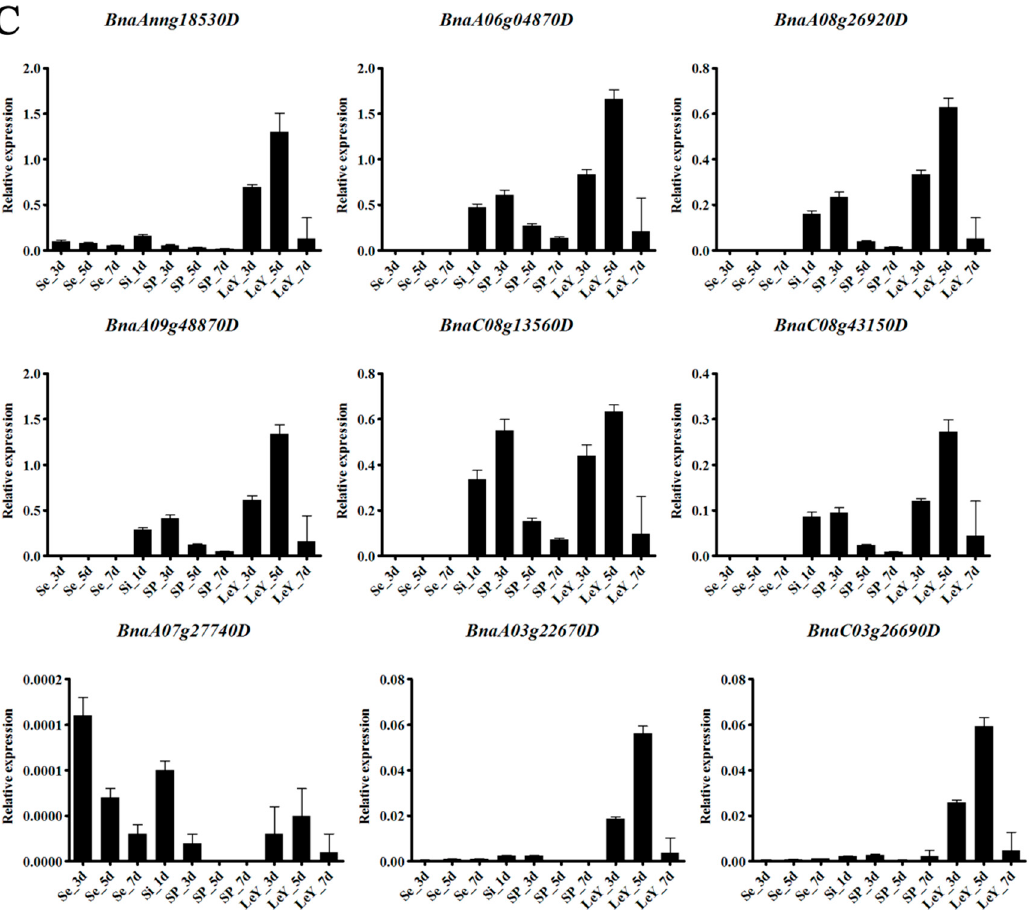
Figure 7. Relative expression of nine BnaYAB genes in different tissues and growth stages of B. napus . Relative expression levels in different tissues at the initial flowering stage ( A ), at the full flowering stage ( B ), and during the green pod stage ( C ). The abbreviations along the x -axes represent the different samples (Table S6). A red box indicates that the gene is only highly expressed in one tissue.